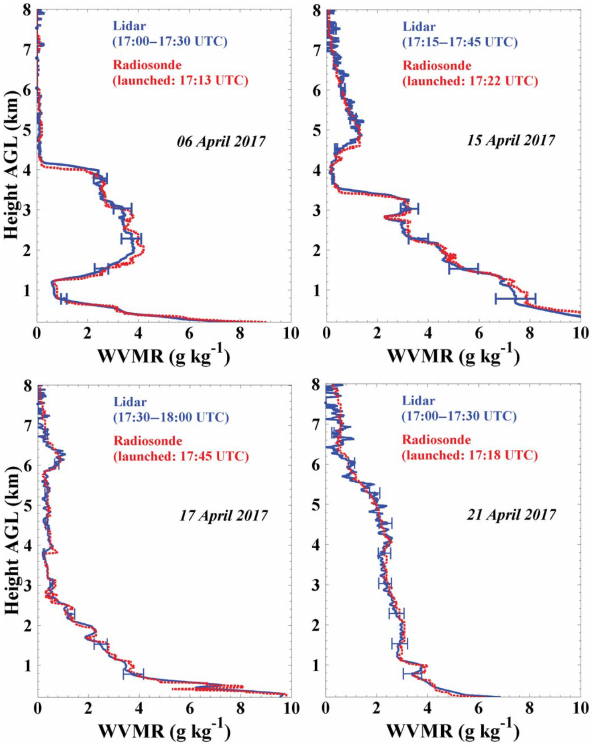
Figure 9. Comparison of water vapor mixing ratio profiles mea- sured with Polly XT and radiosonde on 6, 15, 17 and 21 April 2017. Error bars indicate the uncertainty in the water vapor mixing ratios measured with Polly XT .